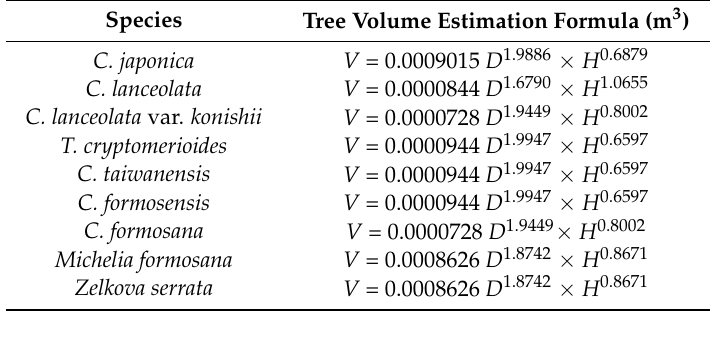
Table 2. Tree volume estimation formulas with respect to diameter (D) and tree height (H) for different